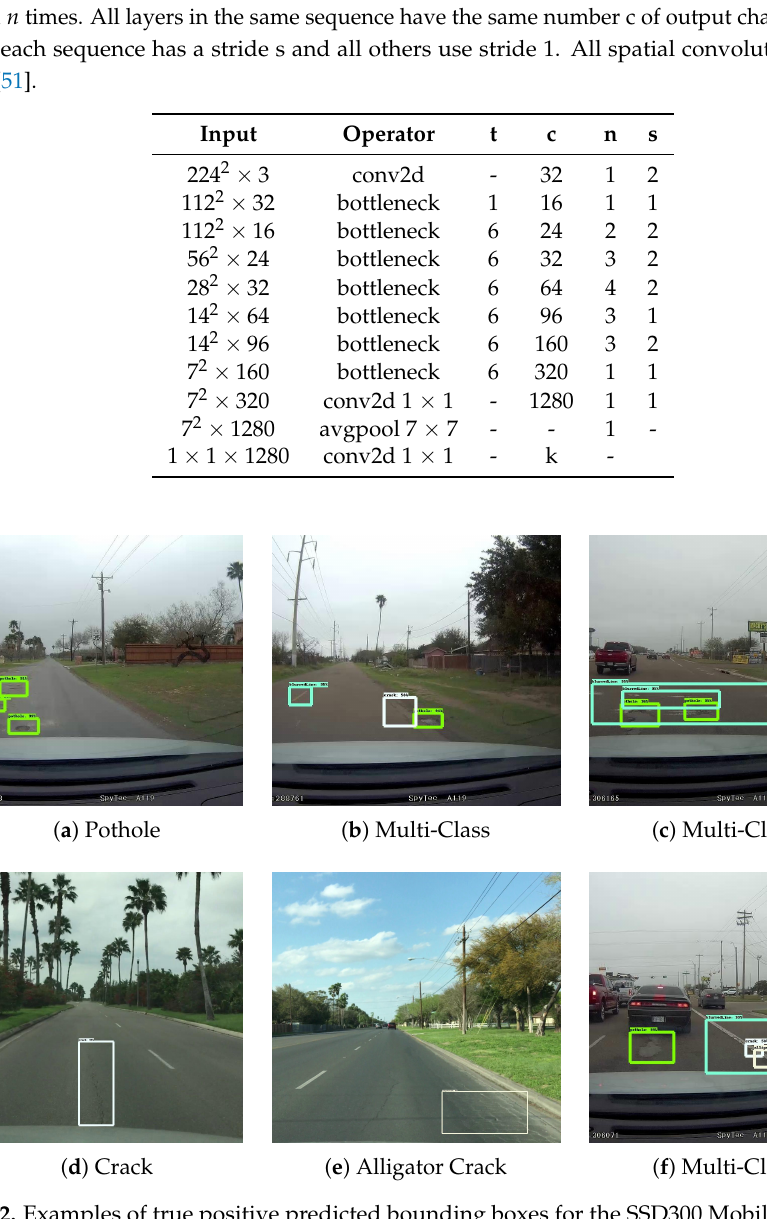
Figure 12. Examples of true positive predicted bounding boxes for the SSD300 MobileNetV2 [19,51] trained